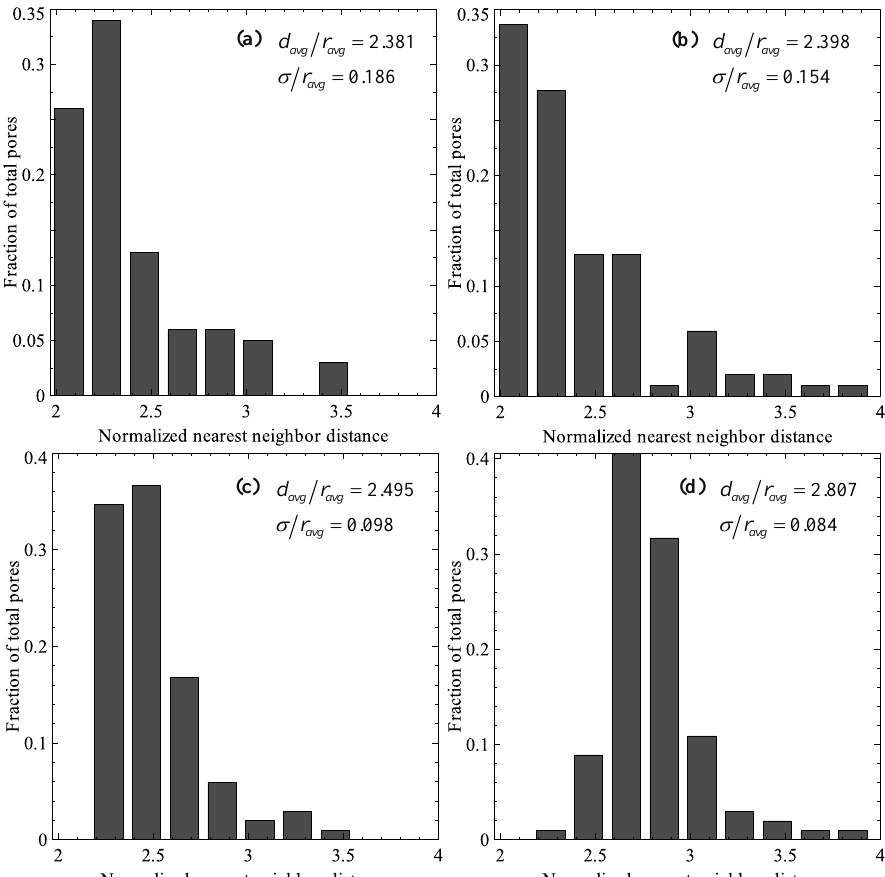
Figure 11. Normalized nearest neighbor distances in membrane RVEs with controlled porosity dispersion.